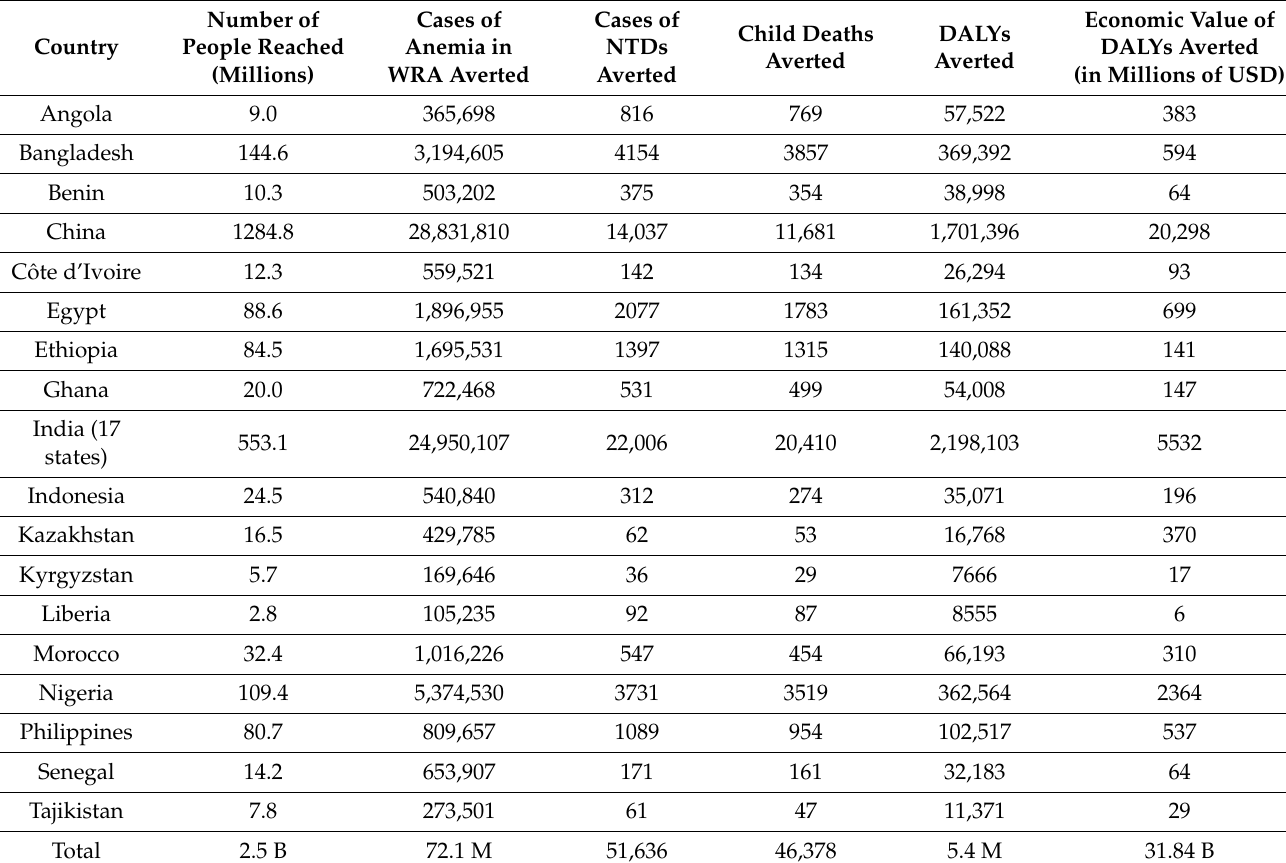
Table 6. Estimated annual health and economic benefits of fortification at scale in countries of